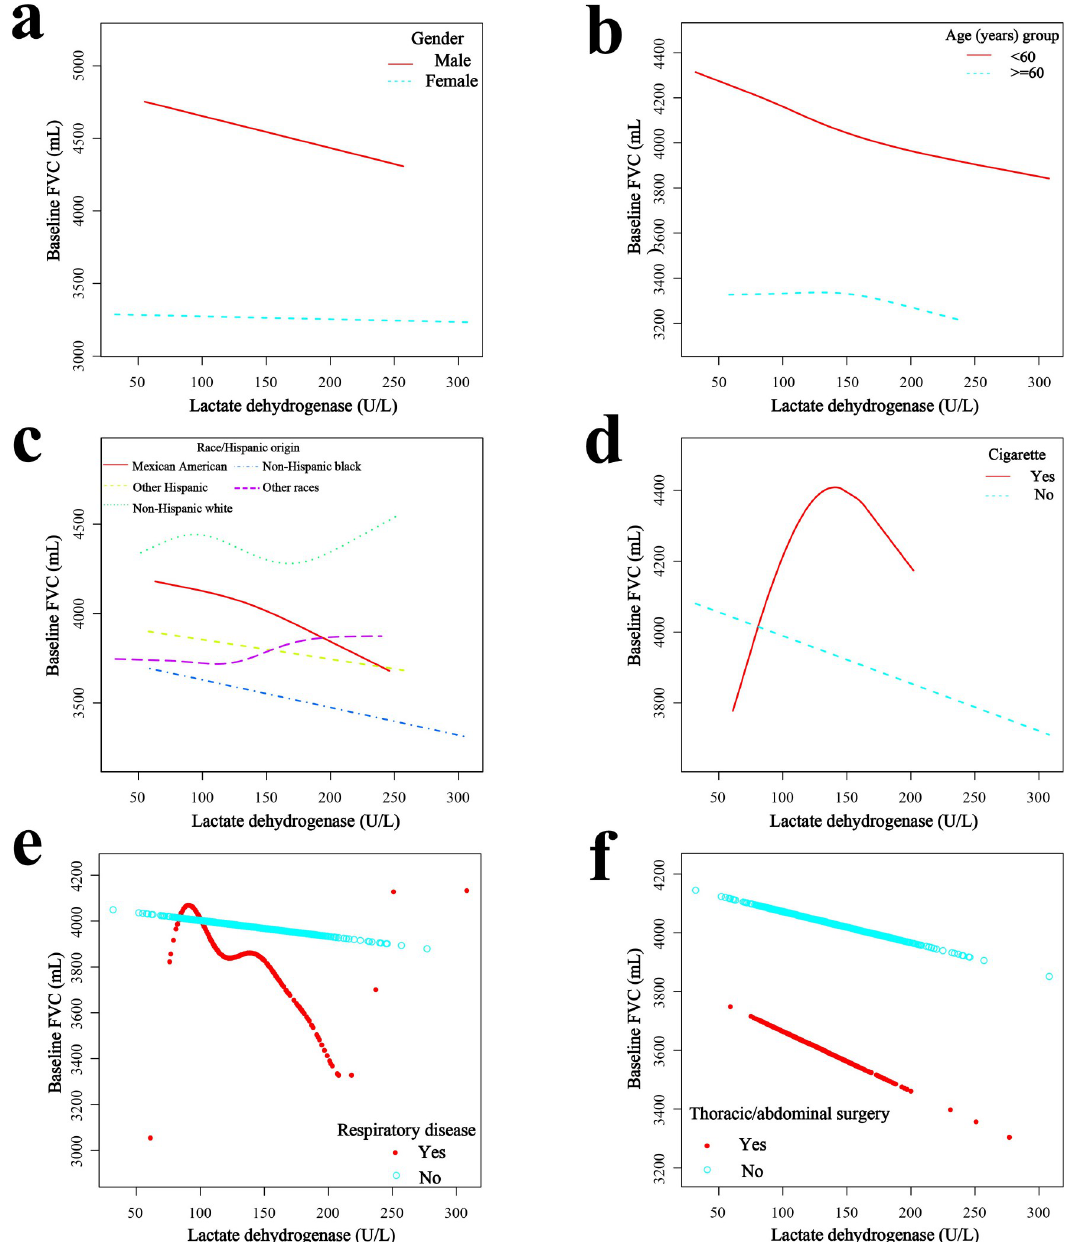
Fig 3. Relationship between serum lactate dehydrogenase and FVC. (a) Stratified by sex. (b) Stratified by age. (c) Stratified by race. (d) Stratified by smoking status. (e) Stratified by respiratory disease. (f) Stratified by surgery. Among non-smokers, LDH was linearly and negatively correlated with both FVC ( β = -1.33, 95% CI = -2.15 to -0.51, P = 0.0015) and FEV1 ( β = -1.11, 95% CI = -1.83 to -0.39, P = 0.0026; Figs 3D and 4D and S5 Table). In those with previous respiratory disease, LDH was linearly negatively associated with both FVC ( β = -2.94, 95% CI = -4.86 to -1.03, P = 0.0028) and FEV 1 ( β = -2.32, 95% CI = -4.11 to -0.52, P = 0.0116). In those without respiratory disease, serum albumin was linearly